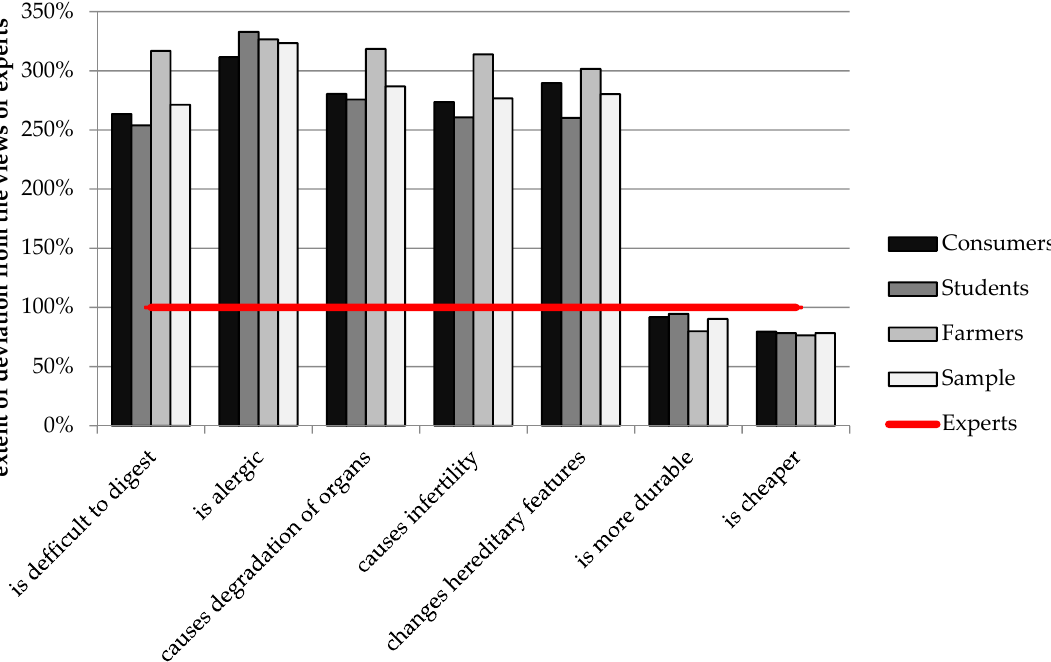
Figure 4. Comparison of the opinions on the features and consequences of GM food between different categories of respondents. Source: Own research.